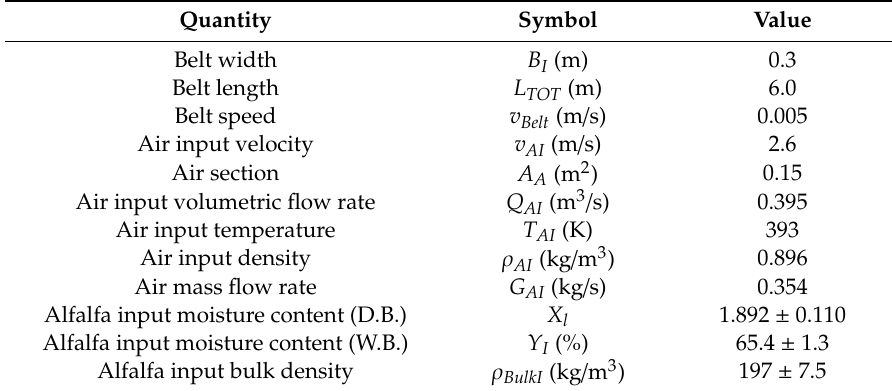
Table 1. Geometrical and operational data of the pilot